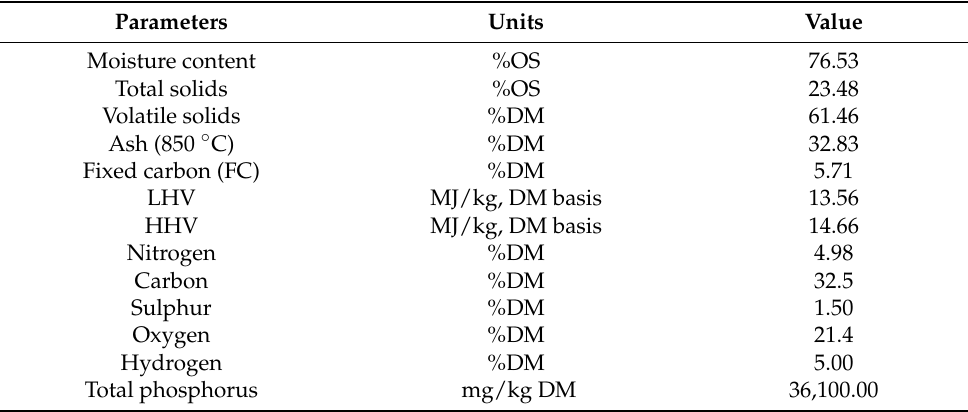
Table 1. Proximate and ultimate analysis of sewage